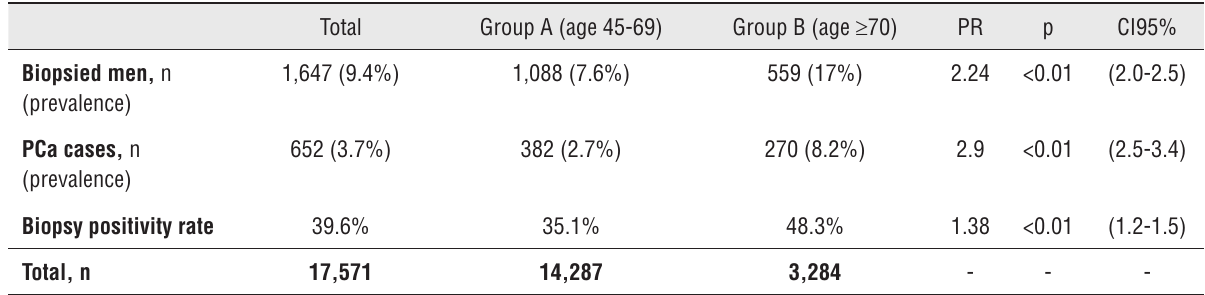
Table 1 - Prostate biopsy results and prostate cancer prevalence.